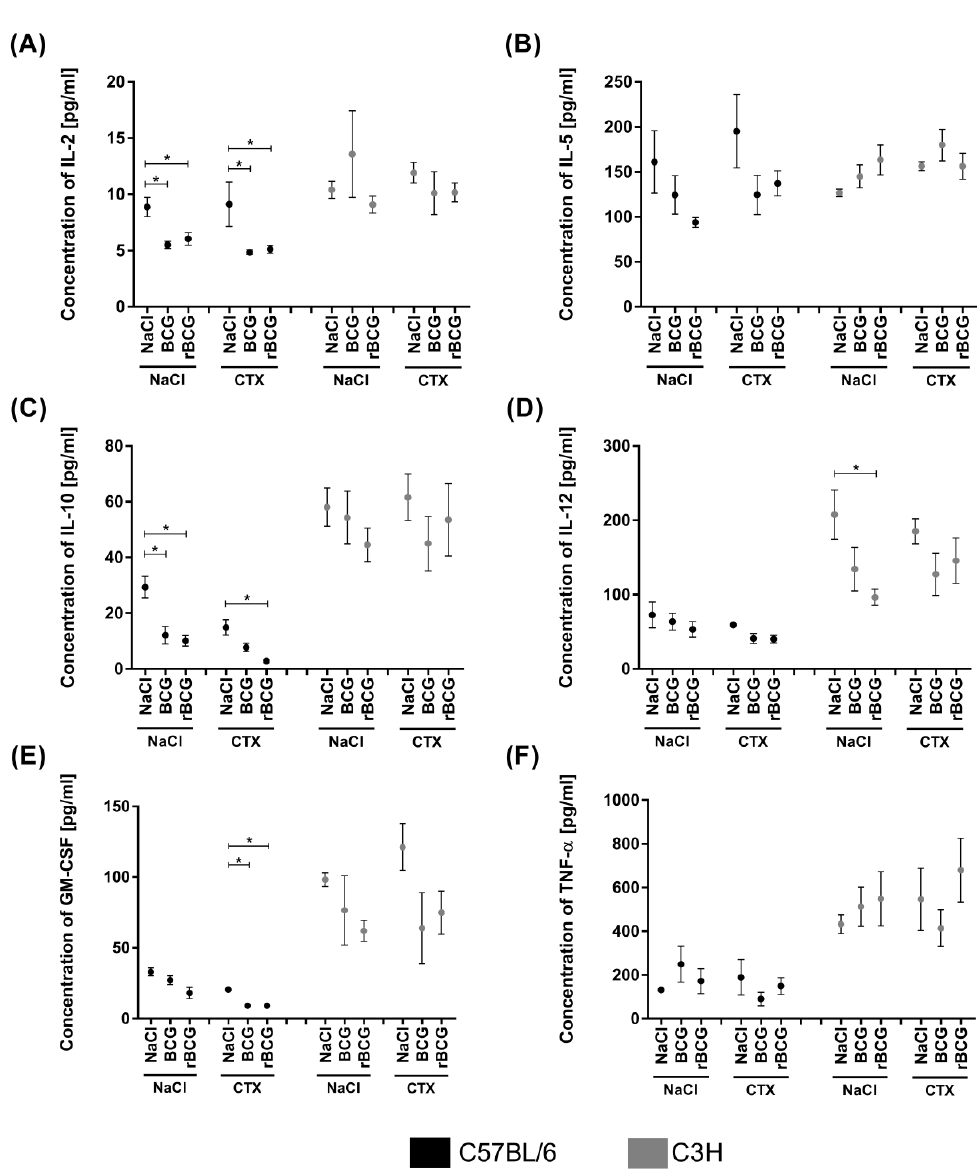
Figure 4. Serum concentrations of the studied cytokines in the sera from C57BL/6 and C3H mice who had been immunized with wild-type BCG or the recombinant BCG strain (rBCG) secreting IL-18 and who were immunocompetent or cyclophosphamide (CTX)-compromised. Data are shown as mean ± SEM (standard error of the mean). For each condition, samples were tested. p values were calculated using a one-way analysis of variance (ANOVA). IL-2 ( A ), IL-5 ( B ), IL-10 ( C ), IL-12 ( D ), granulocyte macrophage colony stimulating factor (GM-CSF) ( E ), tumor necrosis factor alpha (TNF)- α ( F ). Black dots — C57BL/6 mice; grey dots — C3H mice. Asterisk (*) indicates p value ≤ 0.05. 3.5. Effect of BCG and rBCG on the CD4 + and CD8 + T CM and T EM Lymphocytes Response To determine the effects of BCG or rBCG/IL-18 vaccination on the population of T lymphocytes belonging to the CD4 + or CD8 + phenotypes and the population of central memory T cells (T CM ) or effector memory T cells (T EM ) from both phenotypes in mice who were sensitive (C57BL/6) or resistant (C3H) to BCG, the splenocytes from immunocompe- tent and CTX-immunocompromised mice who were non-immunized or immunized with the wild-type BCG or rBCG/IL-18 were analyzed by flow cytometry after staining the spe- cific CD molecules. The flow results are shown in Figure 5.